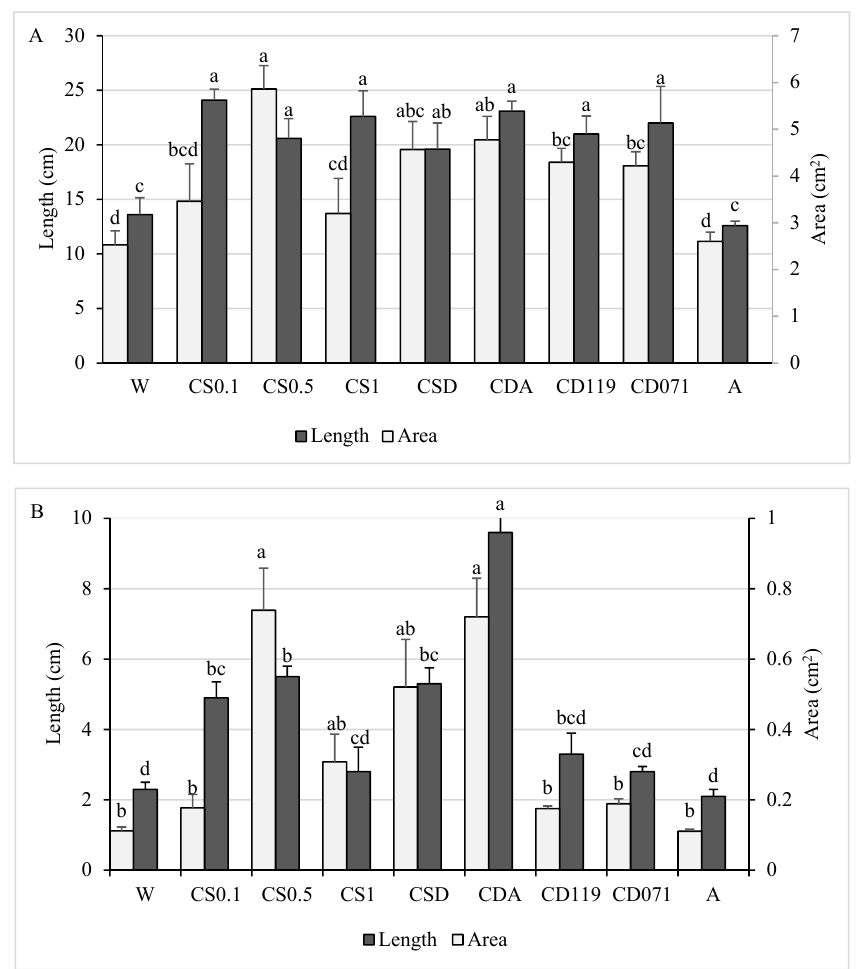
Figure 4. Effect of coatings with chitosan on bean and sesame seeds on their post-germination physiology. ( A ) Root length and root area of bean plantlets. ( B ) Root length and root area of sesame plantlets. Means with the same column letter indicate that they are statistically equal (Tukey, p < 0.05) .